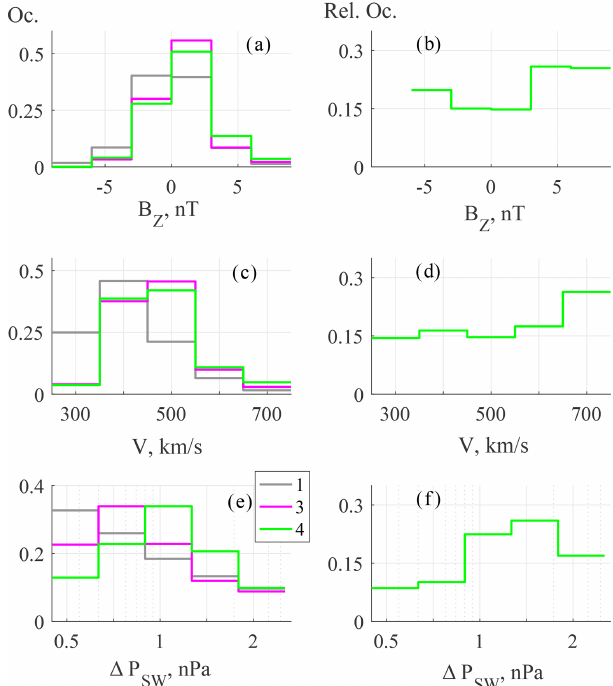
Figure 14. Left panels show SW/IMF parameter distributions for groups 1, 3 and 4: IMF B Z (a) , V (c) and (cid:49)P SW (e) . Right panels show the same for group 4 relative occurrence: B Z (b) , V (d) and (cid:49)P SW (f)